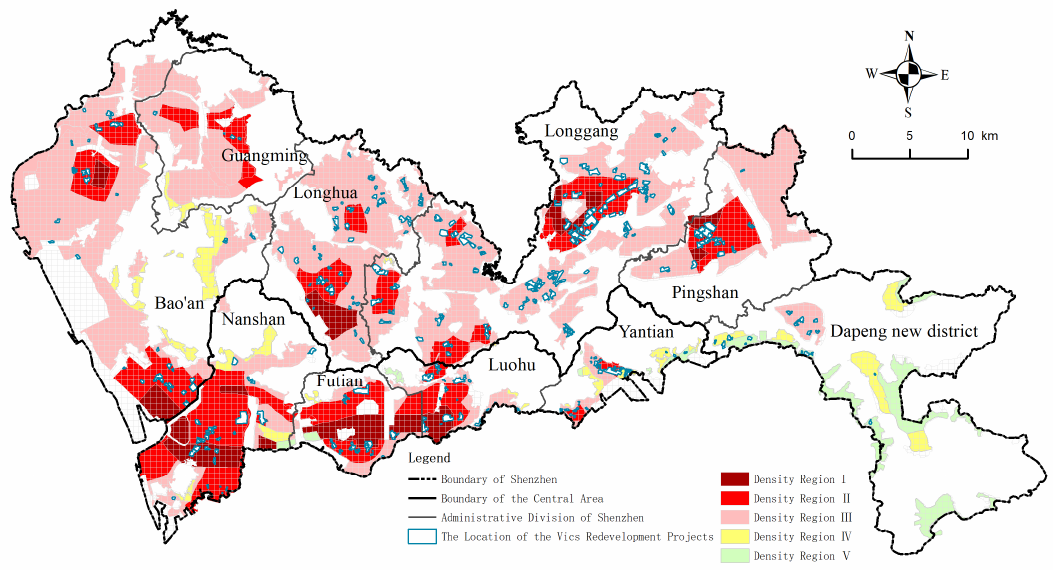
Figure 12. Distribution of urban village redevelopment overlay density zones.